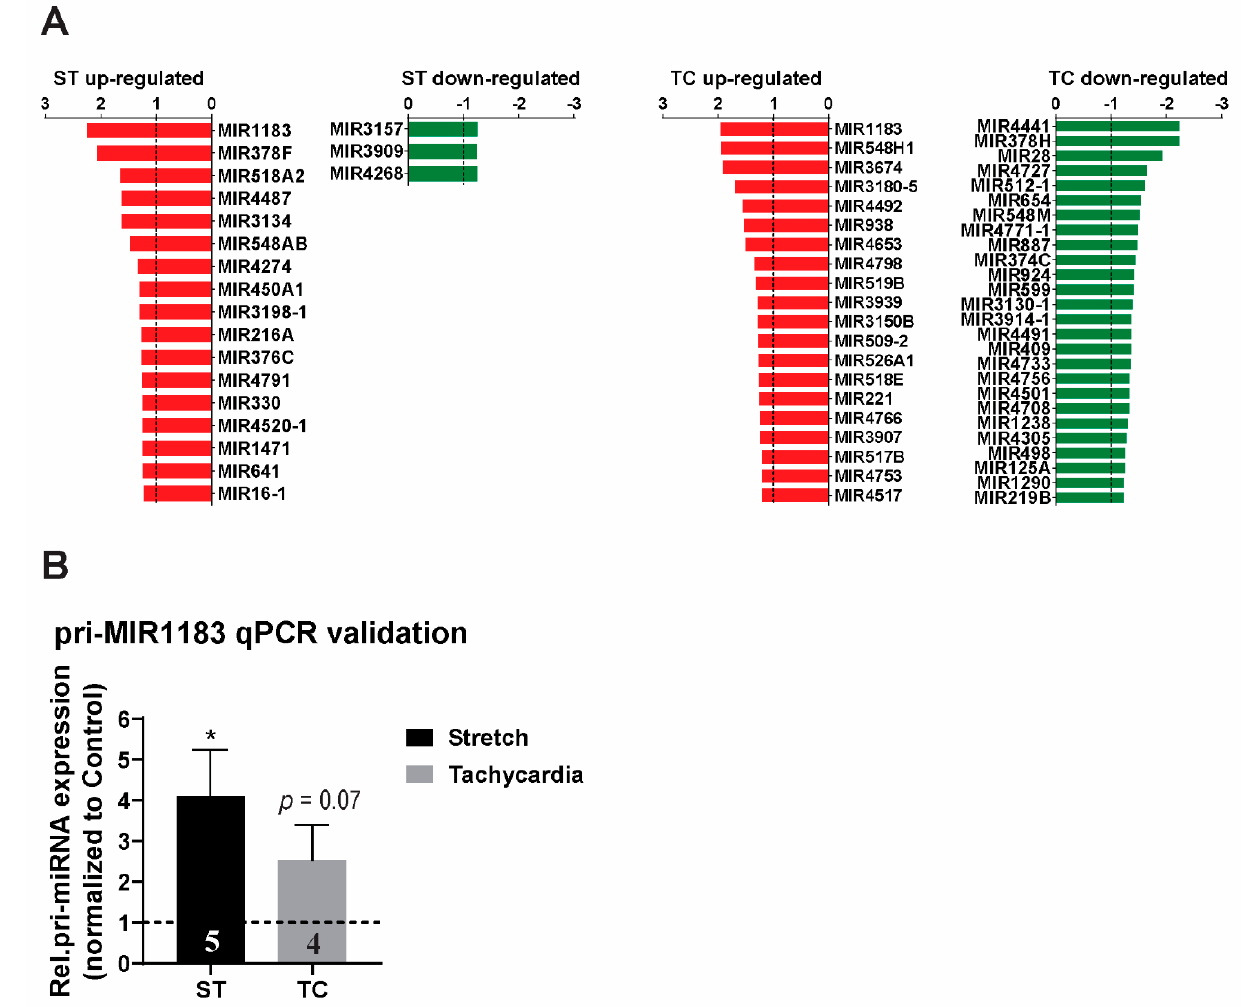
Figure 3. MicroRNA expression profile of ST and TC in human atrial trabeculae. ( A ) Microarray expression profile for precursors of miRNA in human atrial muscle strips regulated by ST or TC with p < 0.05 and fold-change cut-off of at least 1.2-fold up- or − 1.2 down-regulated, n = 4–5 hearts per group. ( B ) pri-miR-1183 expression showed the highest fold change and was validated by qPCR in human atrial muscle strips. One-way ANOVA for microarrays and paired-sample t -test for qPCR, * p < 0.05, n -number of hearts per group is indicated within bar charts. Table 2. Baseline characteristics of sinus rhythm (SR) and atrial fibrillation (AFIB) groups of patients that underwent surgical interventions and provided atrial muscle strip